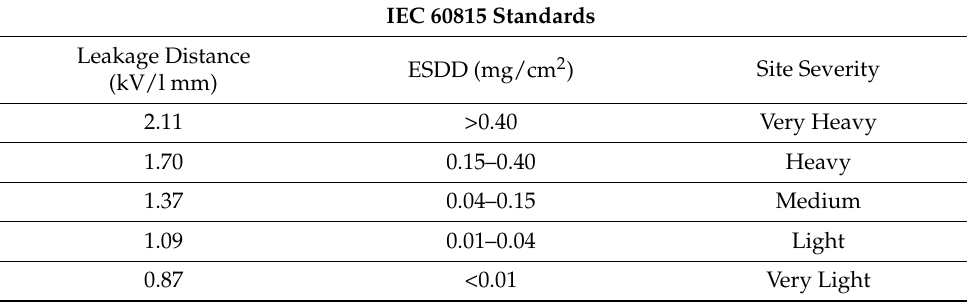
Table 1. The IEC 60815 standard for contamination level classification